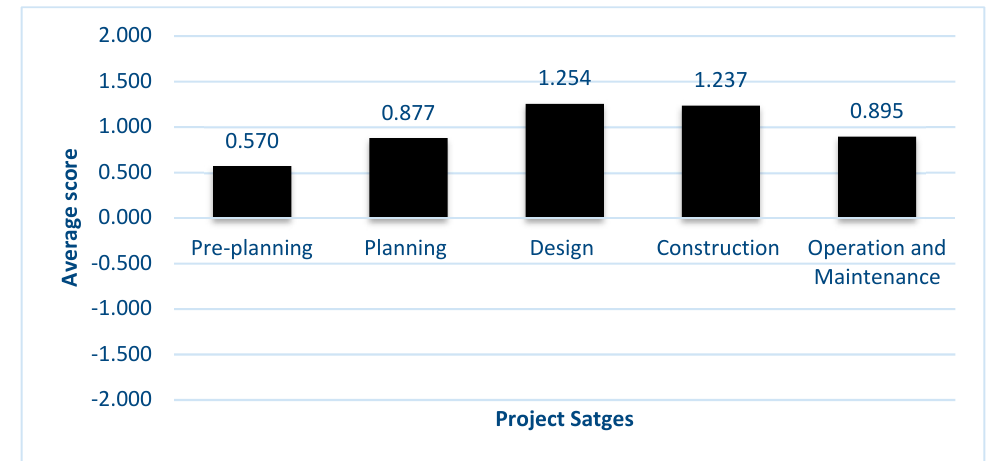
Figure 5. Benefit of BIM in various rail project stages.